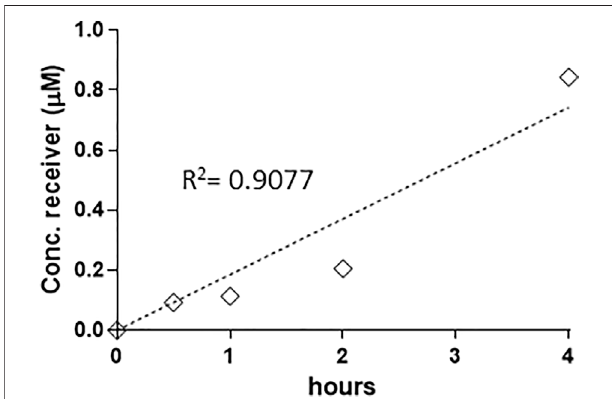
FIGURE1| LinearincreaseofMC-RR(40 µM)absorptionupto4 h(0.5, 1, 2 and 4 h). Absorption has been de fi ned as the recovery (expressed as concentrationinthereceiverBLcompartment),sincenotoxinwasdetectedin the cellular compartment. The permeability rate value (Papp AP-BL) is Papp x 10 – 7 5.73 cm/s. Two independent experiments on different tissue lots from the same donor have been carried out each in